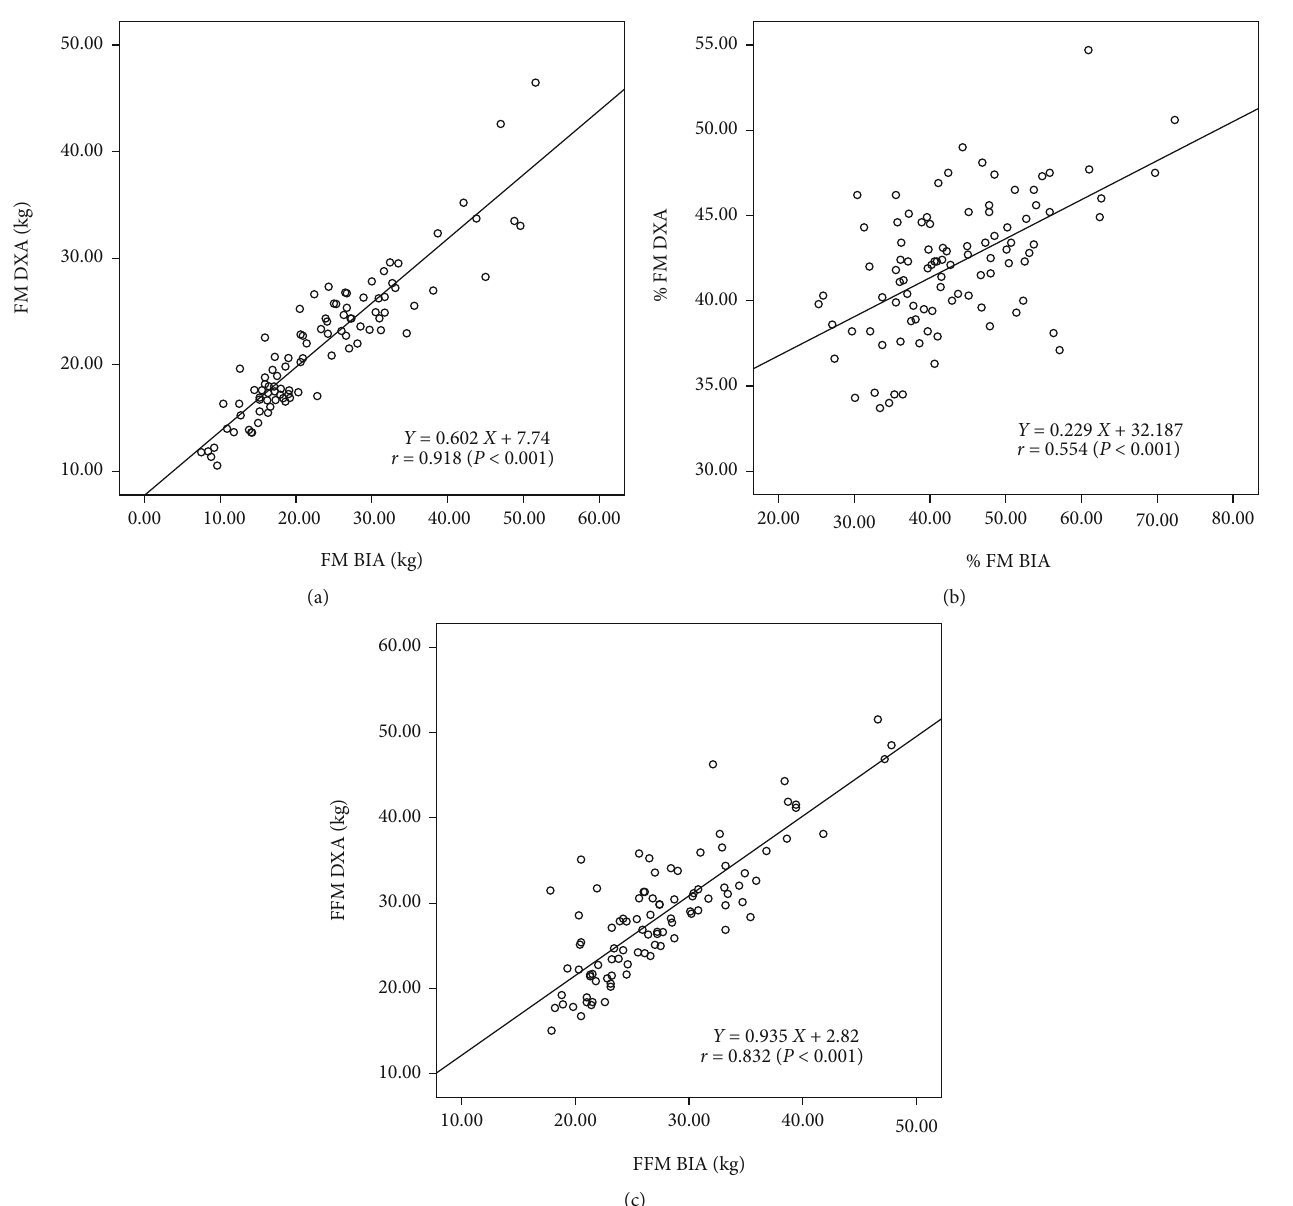
Figure 1: Regression plots between (a) fat mass (FM), (b) percentage fat mass (%FM), and (c) fat-free mass (FFM) assessed by DXA and